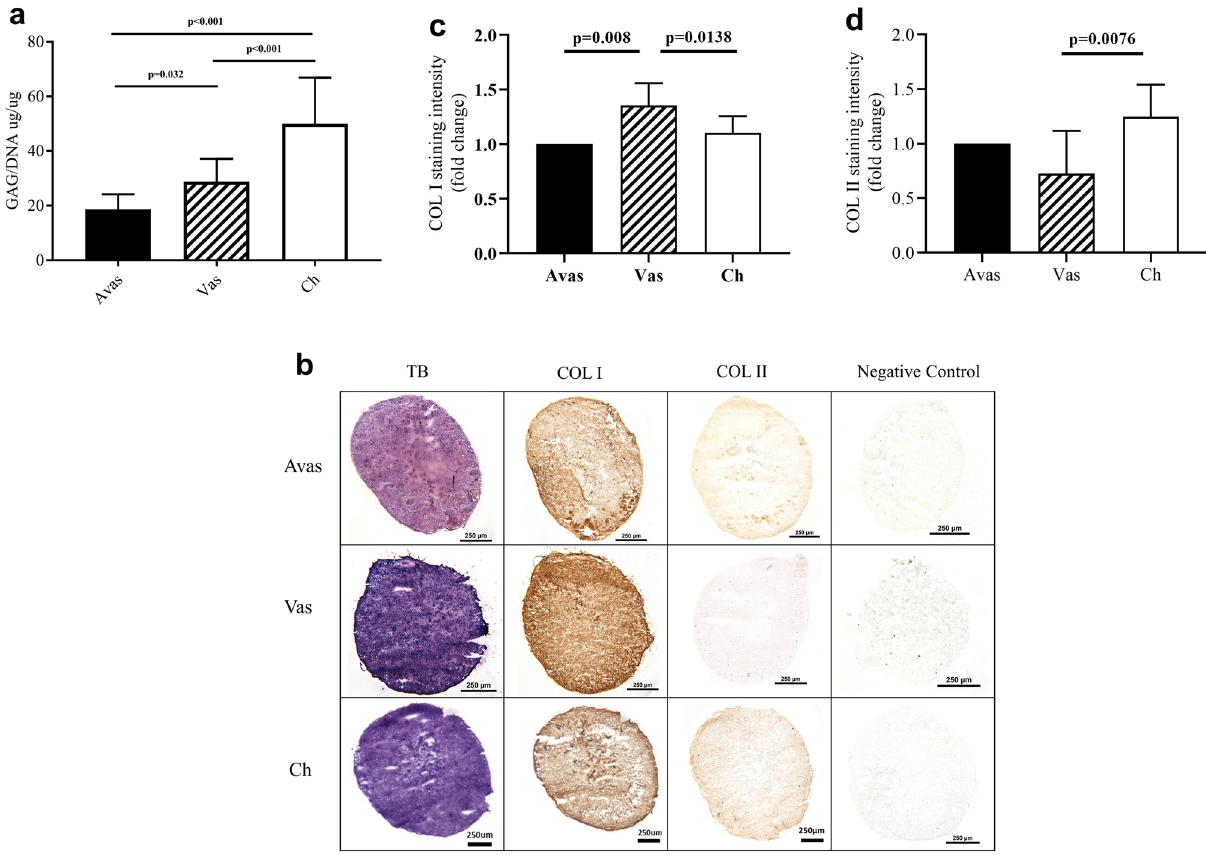
Figure 7. The chondrogenic assessment of avascular and vascular meniscal cells and chondrocytes. ( a ) GAG/ DNA quantitation after 28 days of culture in pellets, a comparison of Avascular (Avas) and Vascular (Vas) meniscal cells and chondrocytes (Ch). Data shown are the means ± the standard deviation of triplicate runs and 6 donors for each cell population. ( b ) Histological analysis of a representative donor 6, chondrogenic pellet sections from Avas, Vas, Ch showing toluidine blue (TB), collagen type I (COL I) and collagen type II (COL II) staining. Scale bars represent 250 μm. ( c ) Collagen type I and (d) collagen type II semi-quantitative